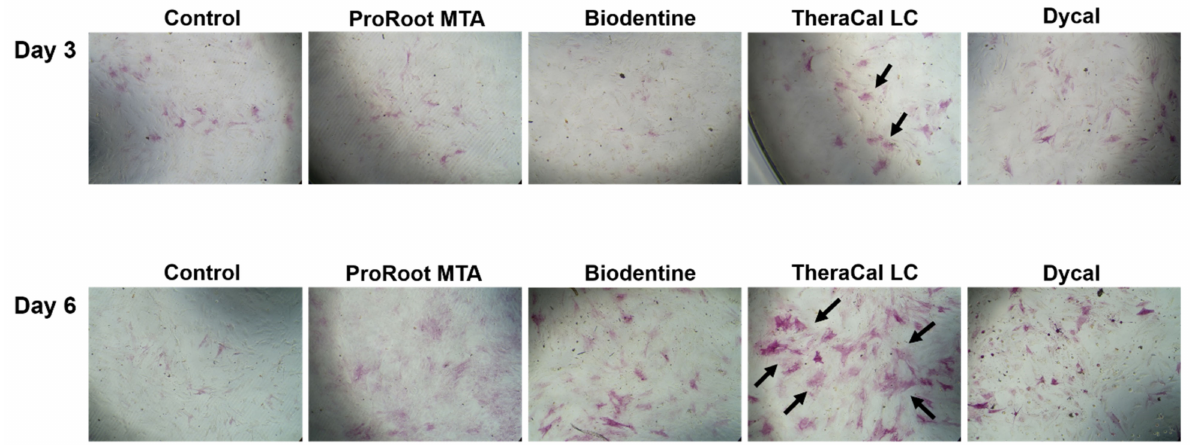
Figure 5. Representative images of alkaline phosphatase (ALP) staining in hDPSCs incubated with eluates of various pulp capping materials. Arrows indicate high ALP staining in the TheraCal LC